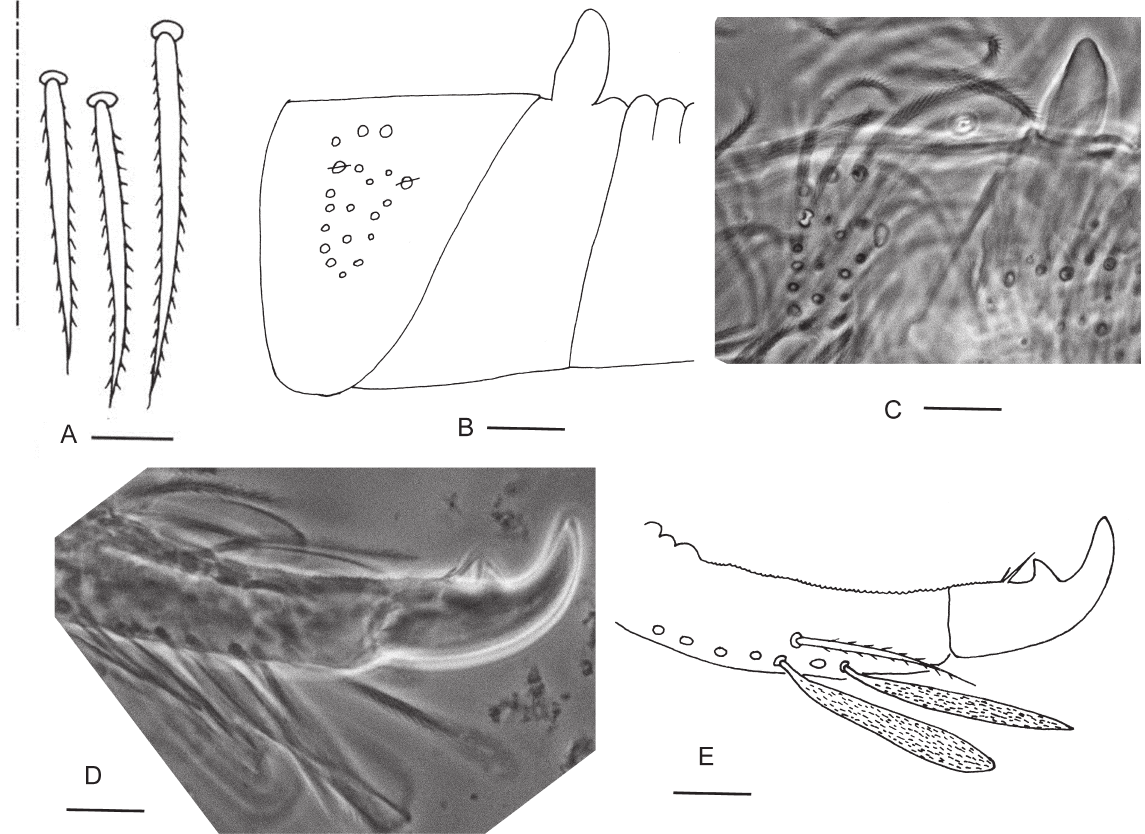
Fig. 9. Lepidocyrtus ( A. ) huizhouensis sp. nov. A . Distal part of ventral manubrium (right side). B–C . Manubrial plaque and proximal part of dens (lateral view). D–E . Distal part of dens and mucro (lateral view). Scale bars: 20